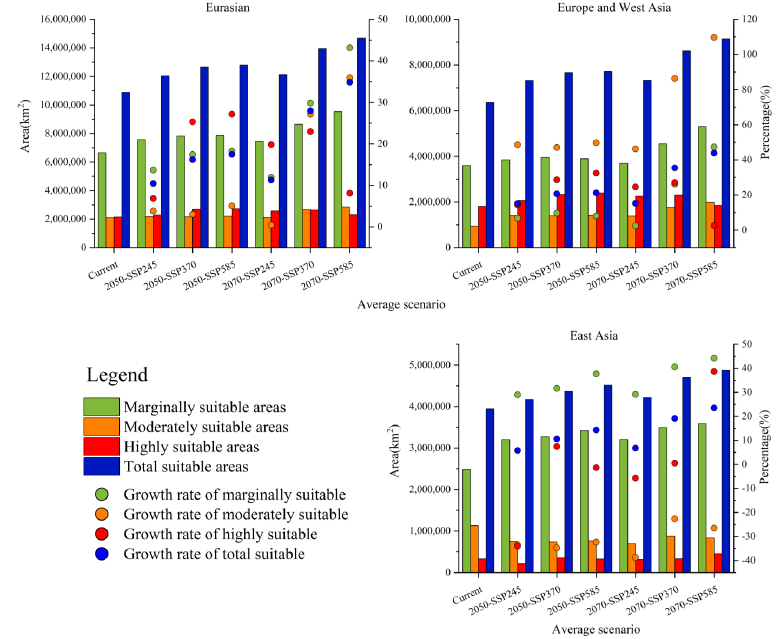
Figure 2. Predicted suitable areas for O. robiniae under present and future climatic conditions (km 2 ) and percentage (%) of increase/decrease (compared to the currently suitable